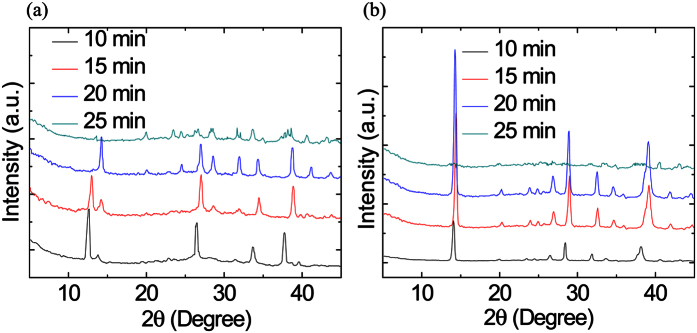
XRD patterns of MAxFA1−xPbI3 films with (a) 10 and (b) 400 sccm H2 flow rates with growth time increasing from 10 to 25 min.